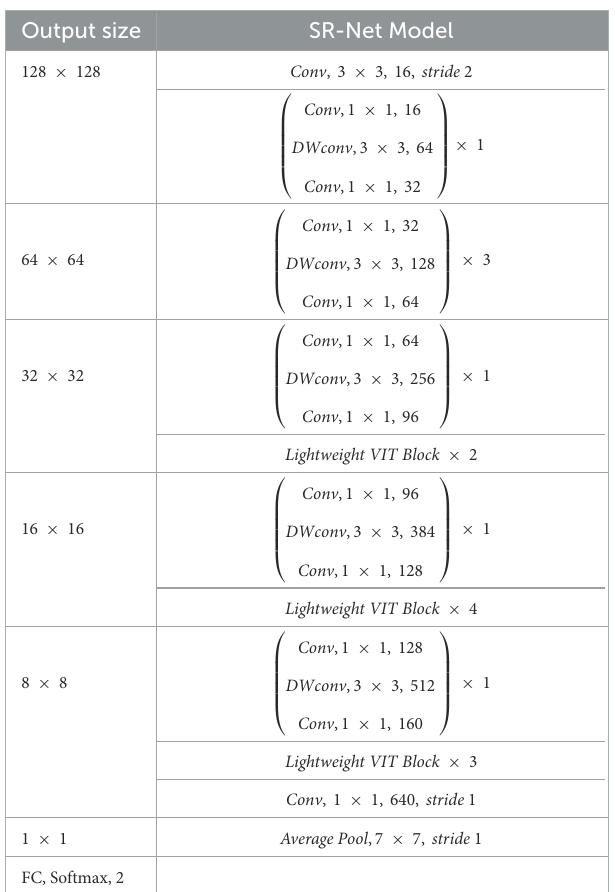
TABLE 3 The network structure of the SR-Net model. Output size